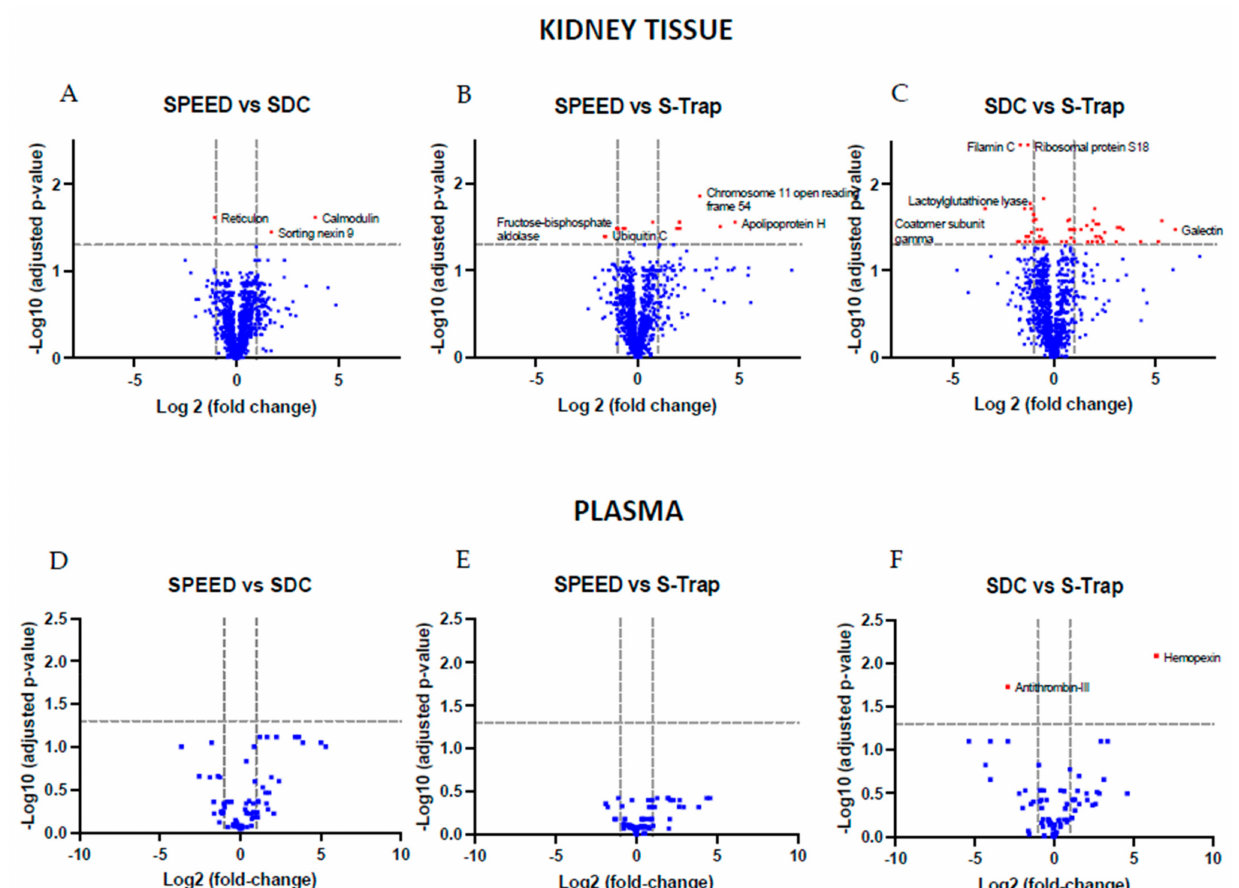
Figure 2. Volcano plots displaying false discovery rate adjusted p -values and fold-changes in SWATH protein intensity between methods in kidney tissue ( A – C ) and plasma ( D – F ). Proteins displayed in red represent those meeting the threshold for differential quantification (a fold-change with an adjusted p -value ≤ 0.05); the horizontal grey dashed line represents p (adjusted) = 0.05. The vertical grey dashed line represents a fold-change of two. In ( A , B , D , E ), protein fold-changes for SDC and S-Trap, respectively, are in reference to SPEED. In ( C , F ), protein fold-changes in S-Trap are with reference to